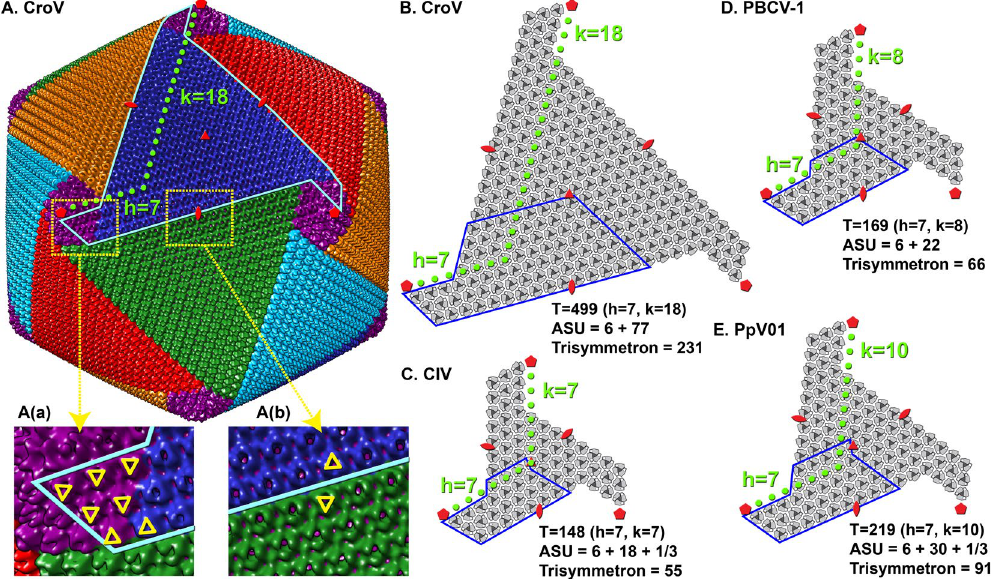
Figure 2. Cryo-EM reconstruction of the CroV virion and capsomer arrangements of other giant icosahedral viruses. ( A ) Reconstruction of the CroV capsid. The isosurface of the map was colored by pentasymmetrons (purple) and trisymmetrons (blue, red, green, cyan and orange). One of the 30 edges of the icosahedron is marked by a cyan line. Two surface areas (a,b) are magnified and selected capsomers are labeled by yellow triangles to show their orientations. ( B – E ) Isolated icosahedral faces of CroV, PBCV-1, CIV and PpV01 capsids are shown schematically. Their T-numbers, asymmetric unit capsomer numbers, and trisymmetron capsomer numbers are listed. 5-fold, 3-fold, and 2-fold symbols are indicated in red and ASUs are outlined in